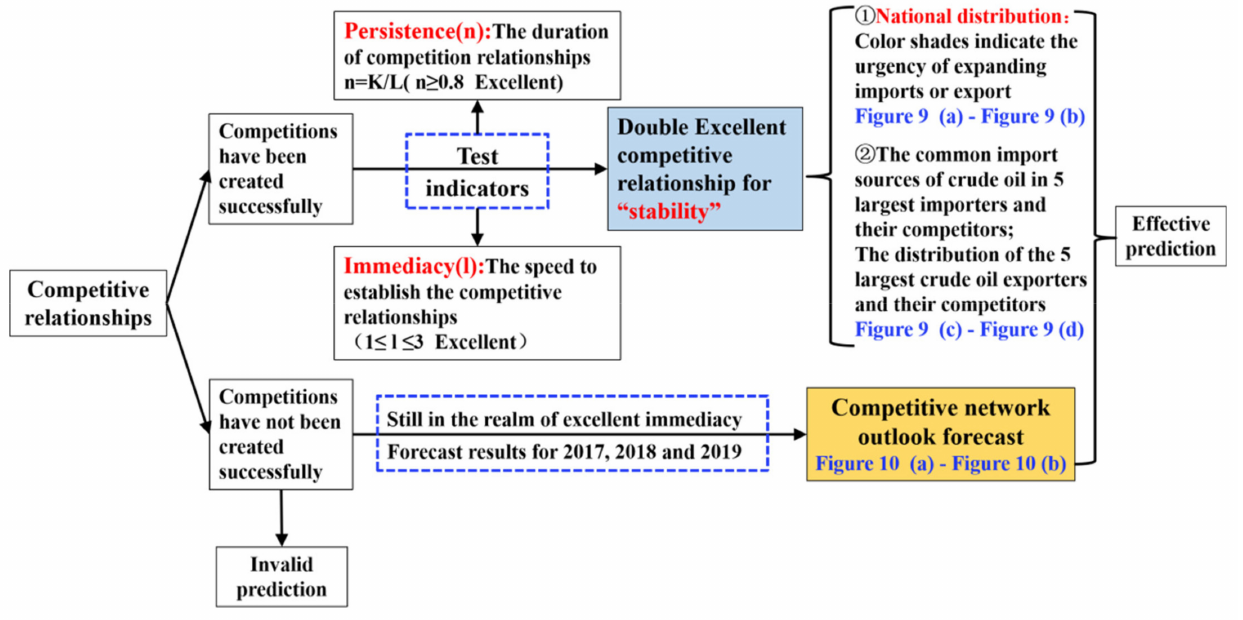
Figure 8. Flow chart for effectiveness test of crude oil